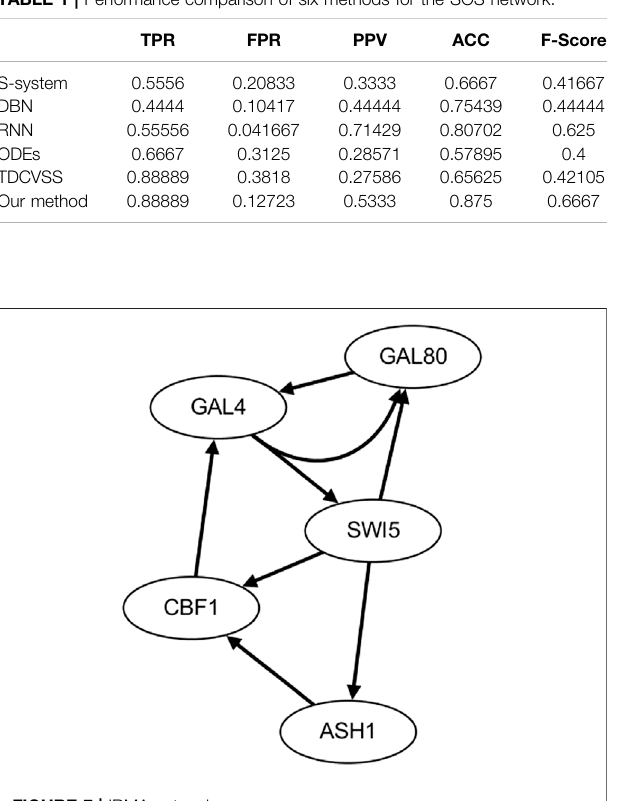
FIGURE 7 | IRMA network. FIGURE 8 | IRMA network by CVTDSS (A) and the IRMA network by TDCC + CVTDSS (B) with the on